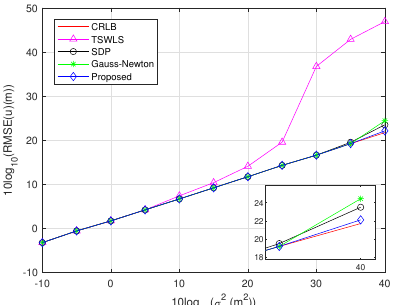
Figure 3. RMSE comparison for estimating target position.